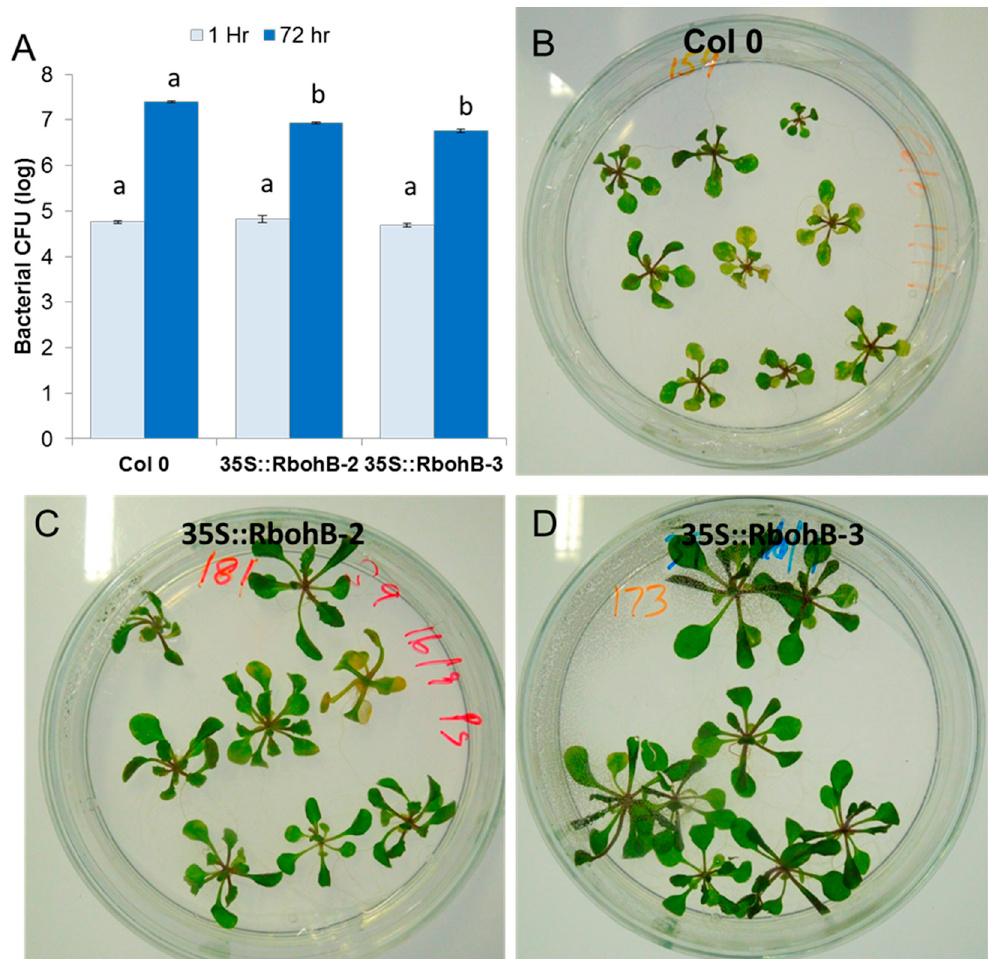
Figure 8. Functional analysis of RbohB overexpression lines in response to P. syringae pv tomato DC3000. A , Overexpression lines and wild type control were infected in plates by the flooding method. Four independent biological replicates were used to collect the data. Data were analyzed for significance difference using ANOVA ( p < 0.05) and LSD with different letters “a” and “b” indicating significant difference. Values are means ± SE. B – D : Phenotypic response of the overexpression lines showed less chlorosis and necrosis at 3 dpi as compared to control wild type.